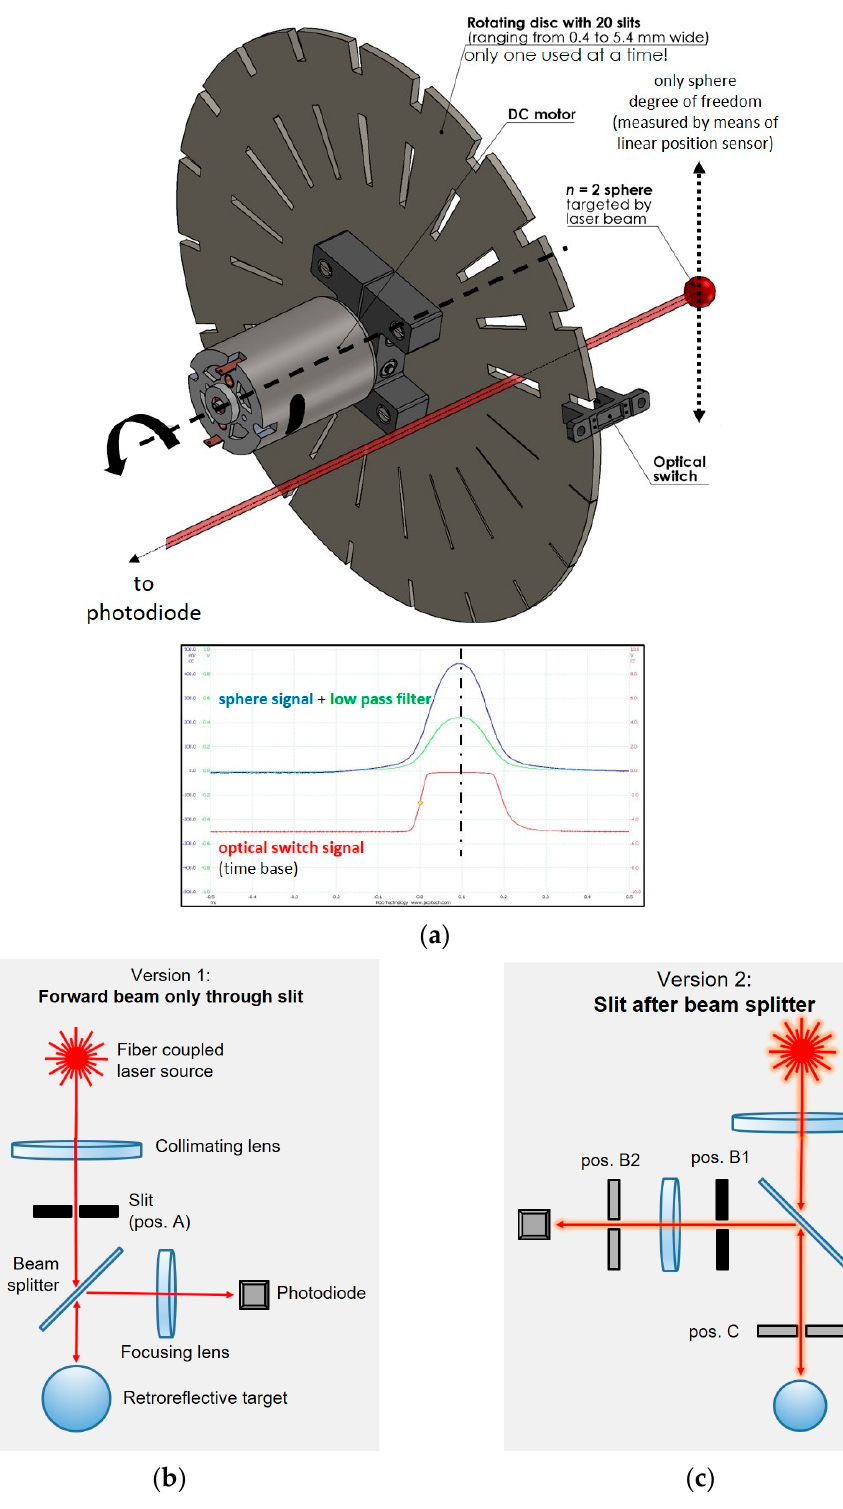
Figure 5. Rotating disc concept and related signals ( a ); layout A ( b ); layouts B1, B2, and C ( c ).